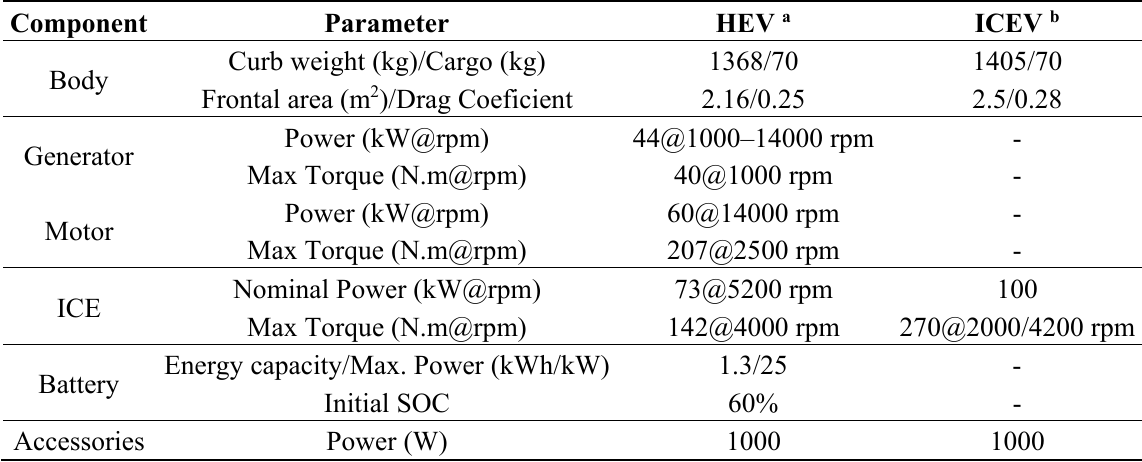
Table 1. Specifications of the HEV and ICEV